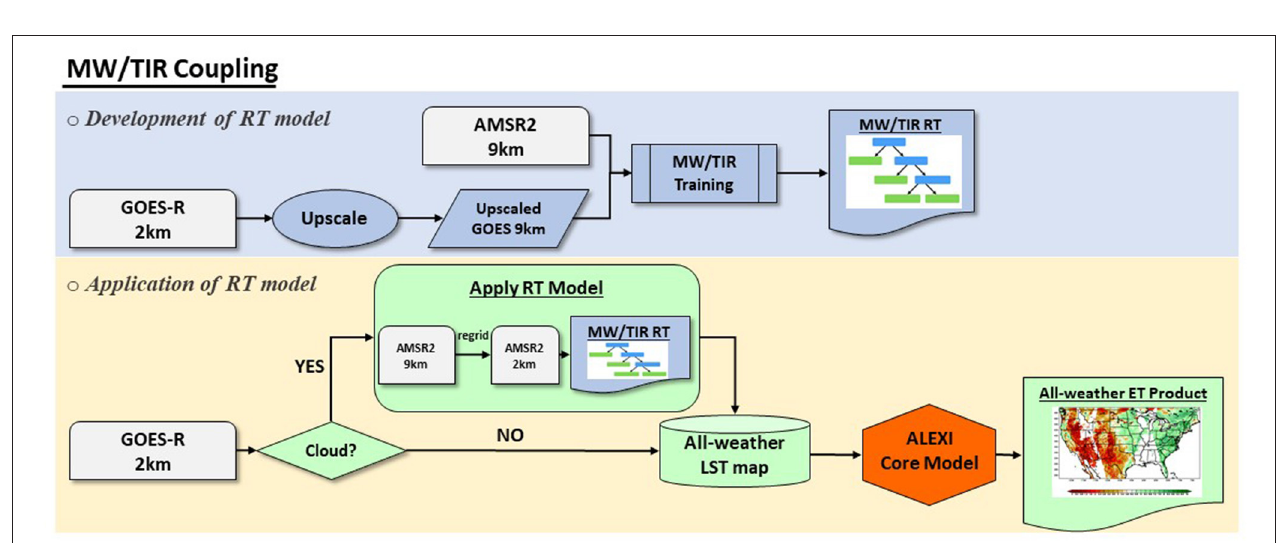
FIGURE 2 | Data flow of the development of the regression tree model for merging microwave (MW) and thermal infrared (TIR)